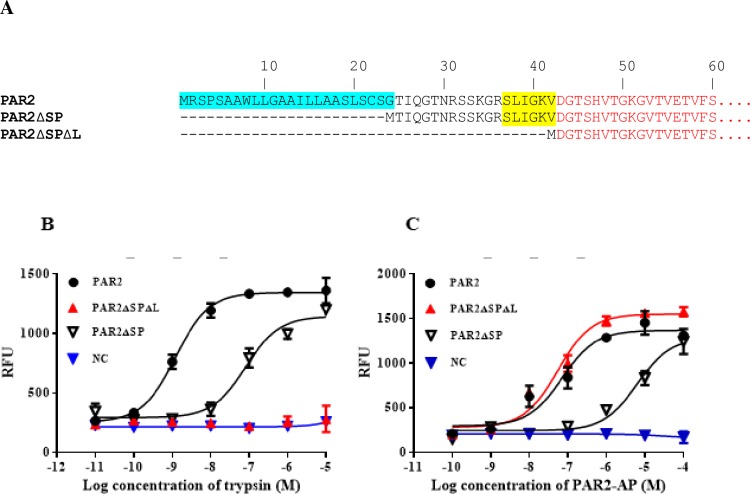
Further deletion of the tethered ligand rescues the functional expression of PAR2 without the signal peptide.A. schematic diagram showing the modifications to PAR2 receptor. The N-terminal extracellular sequences of various PAR2 mutants are shown. Human PAR2 wild type (PAR2), PAR2 with the signal peptide deleted (PAR2ΔSP), PAR2 with the signal peptide deletion and with further deletion to the tether ligand region (PAR2ΔSPΔL). The signal peptide of PAR2 is shown in blue. The tether ligand sequence of PAR2 (SLIGKV) is highlighted in yellow. B, C. Characterization of mutant PAR2 receptors using FLIPR assays. Various PAR2 expression constructs were transiently expressed in HEK293 with par1 and par2 knocked-out. Trypsin (B) or the synthetic agonist peptide PAR2 ligand (PAR2-AP) (C) were used as the ligand to stimulate receptor activation. HEK293 cells with par1 and par2 genes knocked-out were used as the host cells for recombinant expression of various PAR2 receptors. Untransfected cells were used as the negative controls (NC). The experiments were performed in triplicates at each data points and the results shown are mean ± sd. The experiments have been performed 3 times and very similar results have been observed. Example data is shown.